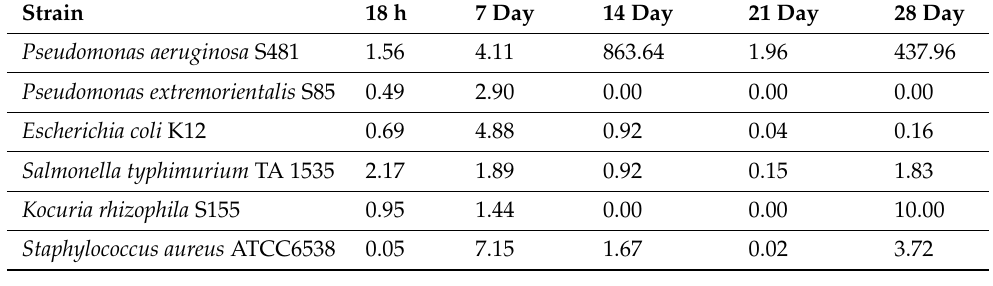
Table 1. Dynamics of changes in the proportion (%) of thermoresistant cells relative to the total number of cells (CFU) in a sample before heating (100%) (in planktonic cultures with agitation). Strain 18 h